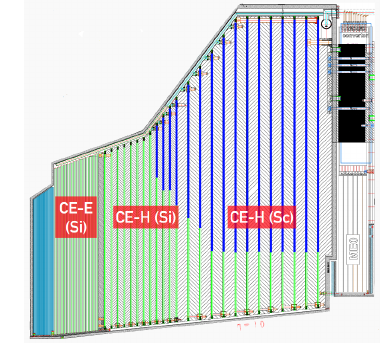
Figure 1. Scheme of the HGCAL subdetector used for this study [1] (not the last design version). Three main kinds of sensors distributed on layers are shown here: the electromagnetic section (CE-E-Si - 28 layers) and the two hadronic sections, one with silicon based sensors (CE-H-Si - 24 layers), the other with scintillator sensors (CE-H-Sc 16